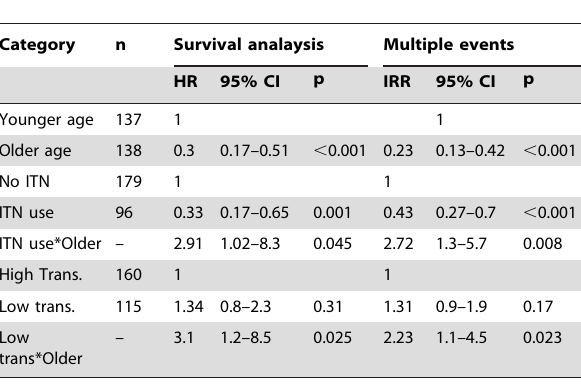
Table 2. The effect of ITN use and residence at low transmission intensity on risk of febrile malaria, and the interactions with age